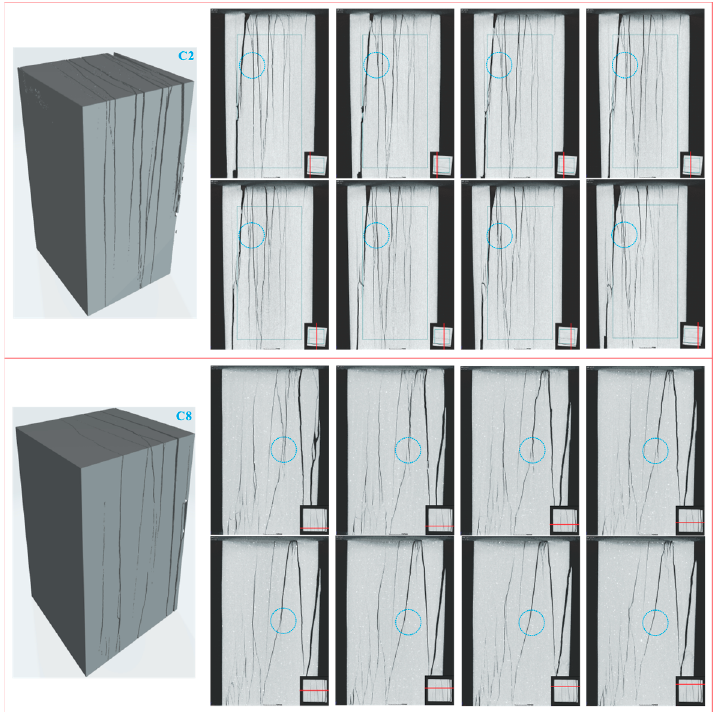
Figure 12. Spatial distribution of cracks inside samples, red line at bottom right corner indicates longitudinal section’s position in top view.